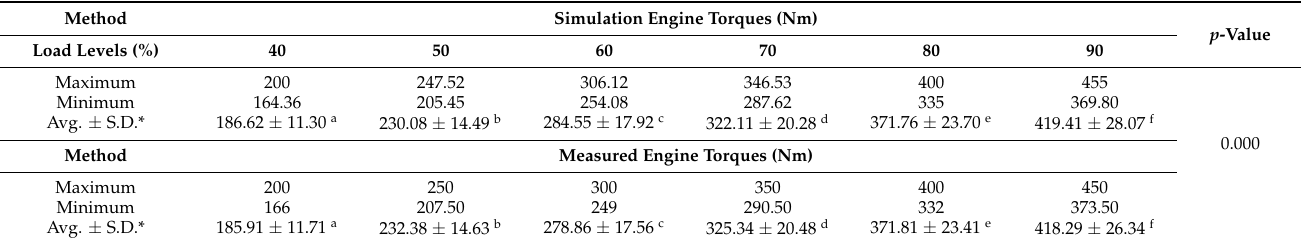
Figure 7. The measured and simulation engine torques at various load levels. Table 3. The statistical analysis of both simulation and measured engine torques at various engine load